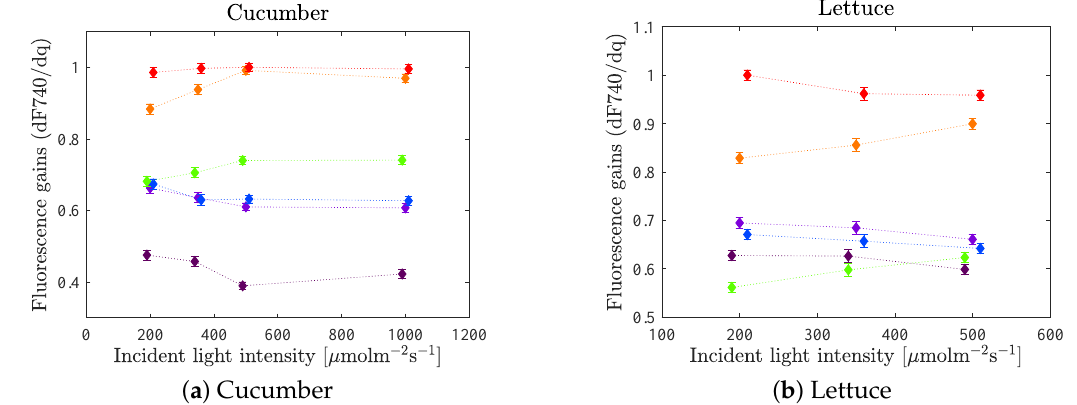
Figure 7. Mean values (and standard errors of the mean) of the fluorescence gains at each intensity level, independent of the background spectra, for ( a ) cucumber and ( b )